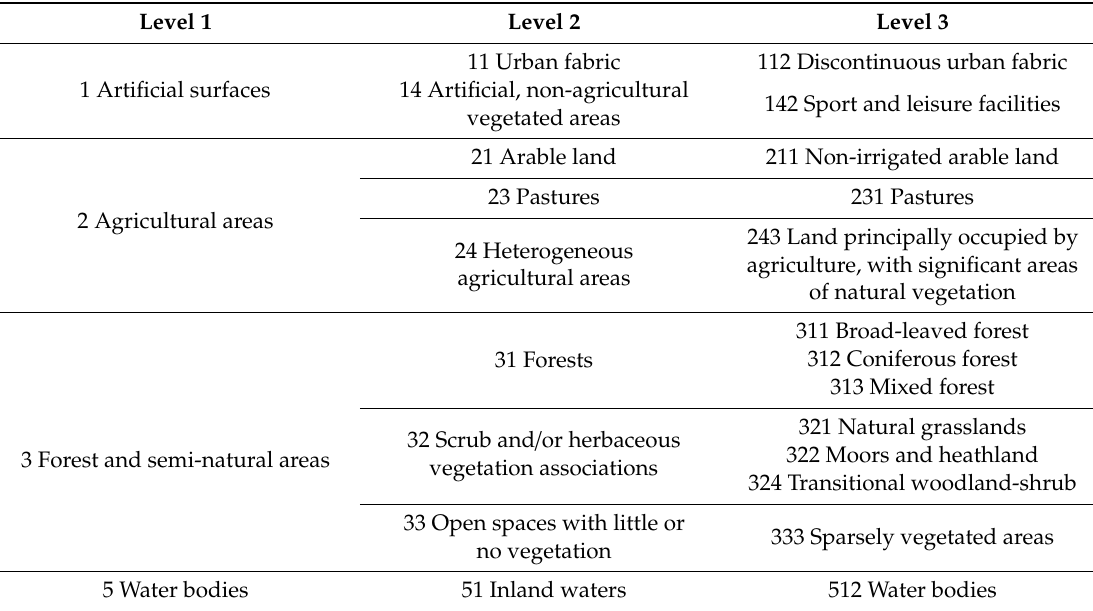
Table 2. CORINE land cover classes in the studied